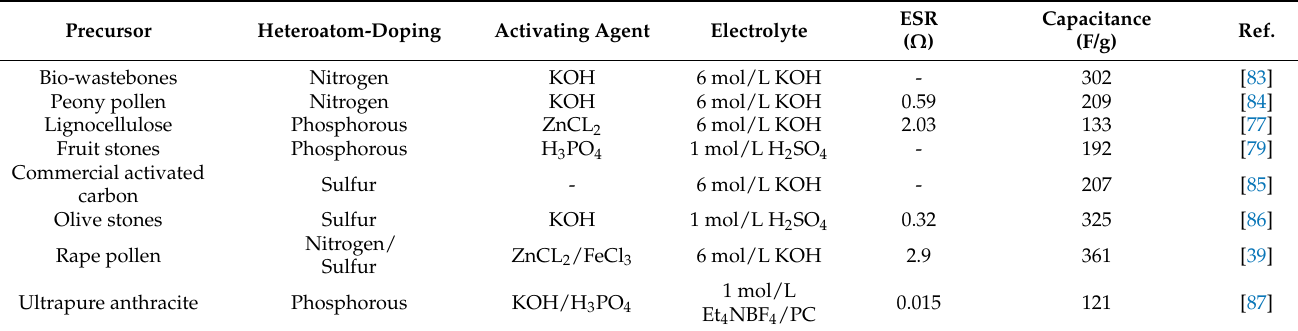
Table 4. Comparison of the specific capacitance and equivalent series resistance parameters of different heteroatoms-doping activated carbons in the